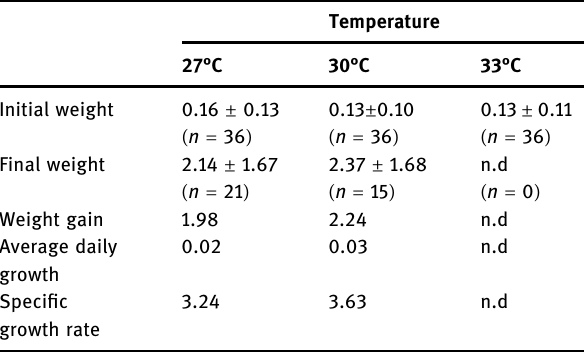
Table 1: Production parameters of the giant freshwater prawn Macrobrachium rosenbergii reared in di ff erent temperature